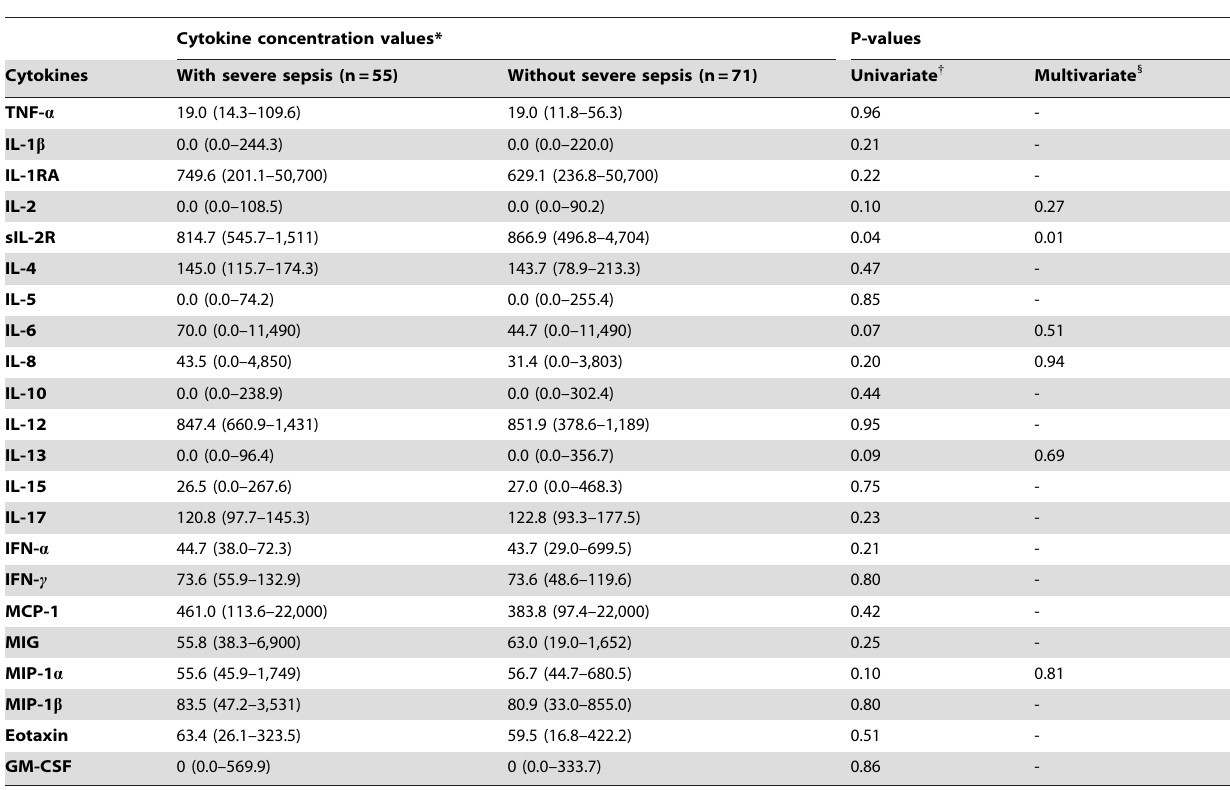
Table 3. Serum concentrations of cytokines in patients with and without severe sepsis.